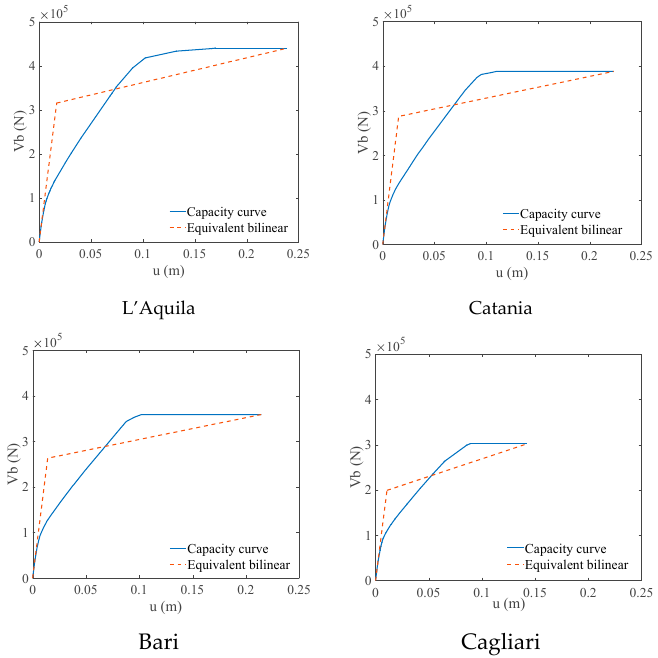
Figure 8. Capacity curves and SDOF constitutive law for each structure location. The total horizontal load Vb is plotted versus the horizontal displacement of the top floor.